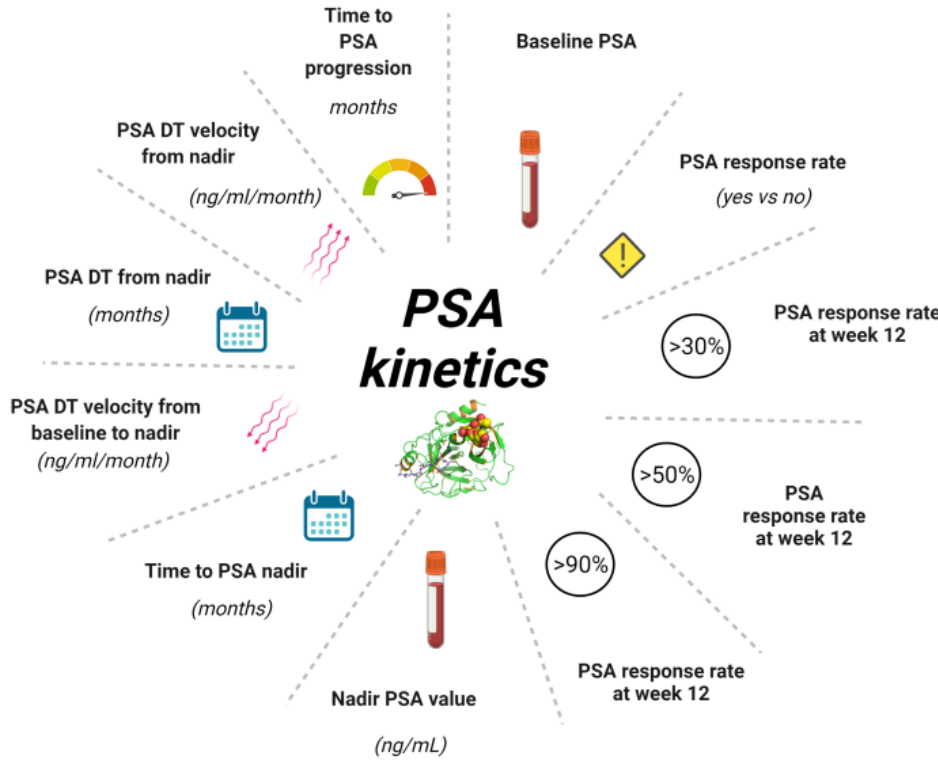
Figure 2. Different parameters of PSA Kinetics. PSA kinetics represents useful tool during the history of prostate cancer from diagnosis to treatment of mCRPC allowing to monitor the follow-up or the efficacy of treatment. Baseline PSA is required at diagnosis and at the beginning of each new treatment. PSA response rate is the eventual decline > 50% in pre-treatment PSA following treatment. PSA response rate at 12 weeks is evaluated in different percentages. The PSA nadir is the lowest value reached during a treatment, another useful indicator is represented by the time in which PSA nadir was reached expressed in months. One of the parameters most commonly used in clinical practice is determination of the dynamics of PSA levels, expressed by PSADT and PSA velocity. These are routinely used in early setting but could be useful also in advanced setting. Abbreviation: PSA, prostate specific antigen; PSA DT, PSA doubling time; mCRPC, metastatic castration resistant prostate cancer.